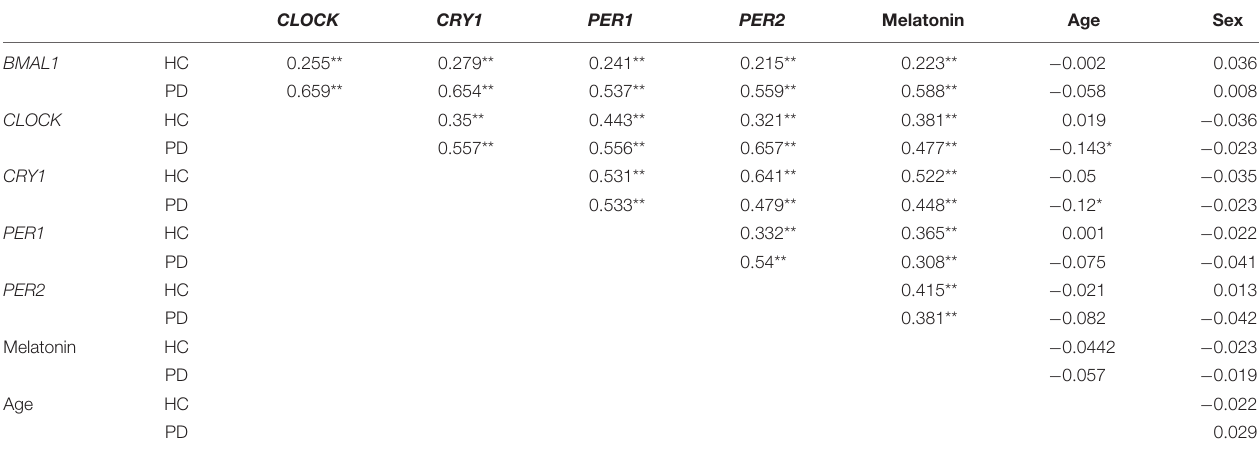
TABLE 2 | The correlation coefficients between the expression levels of clock genes in the PBMCs, plasma melatonin concentration, the age and sex of the PD patients, and